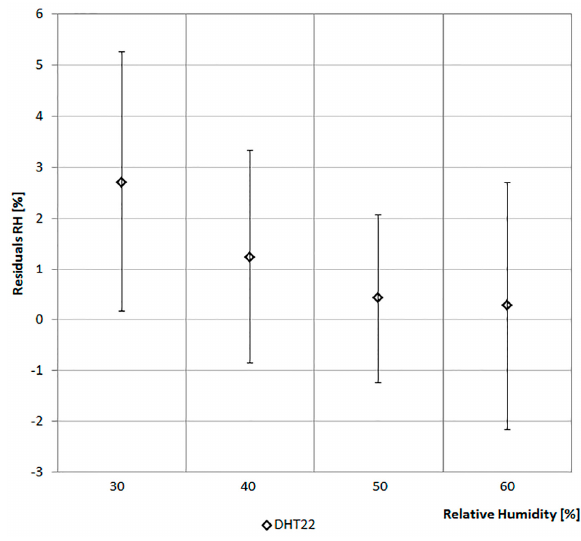
Figure 12. Relative humidity DHT22 data after approximately two years.